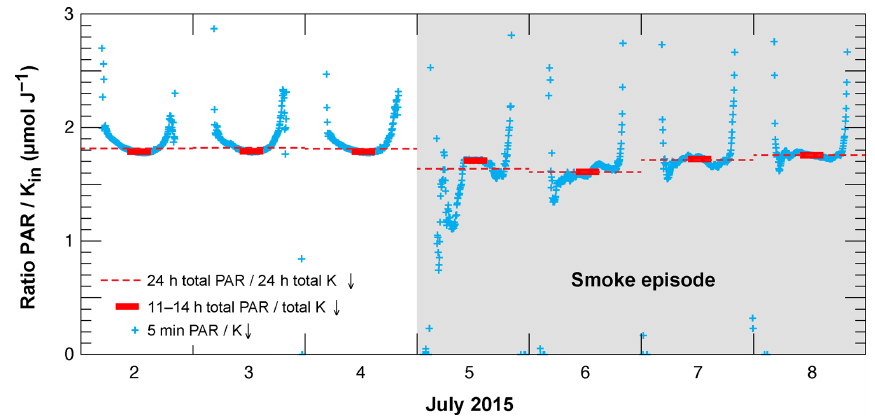
Figure 7. PAR /K ↓ ratio at Burns Bog from 2–8 July